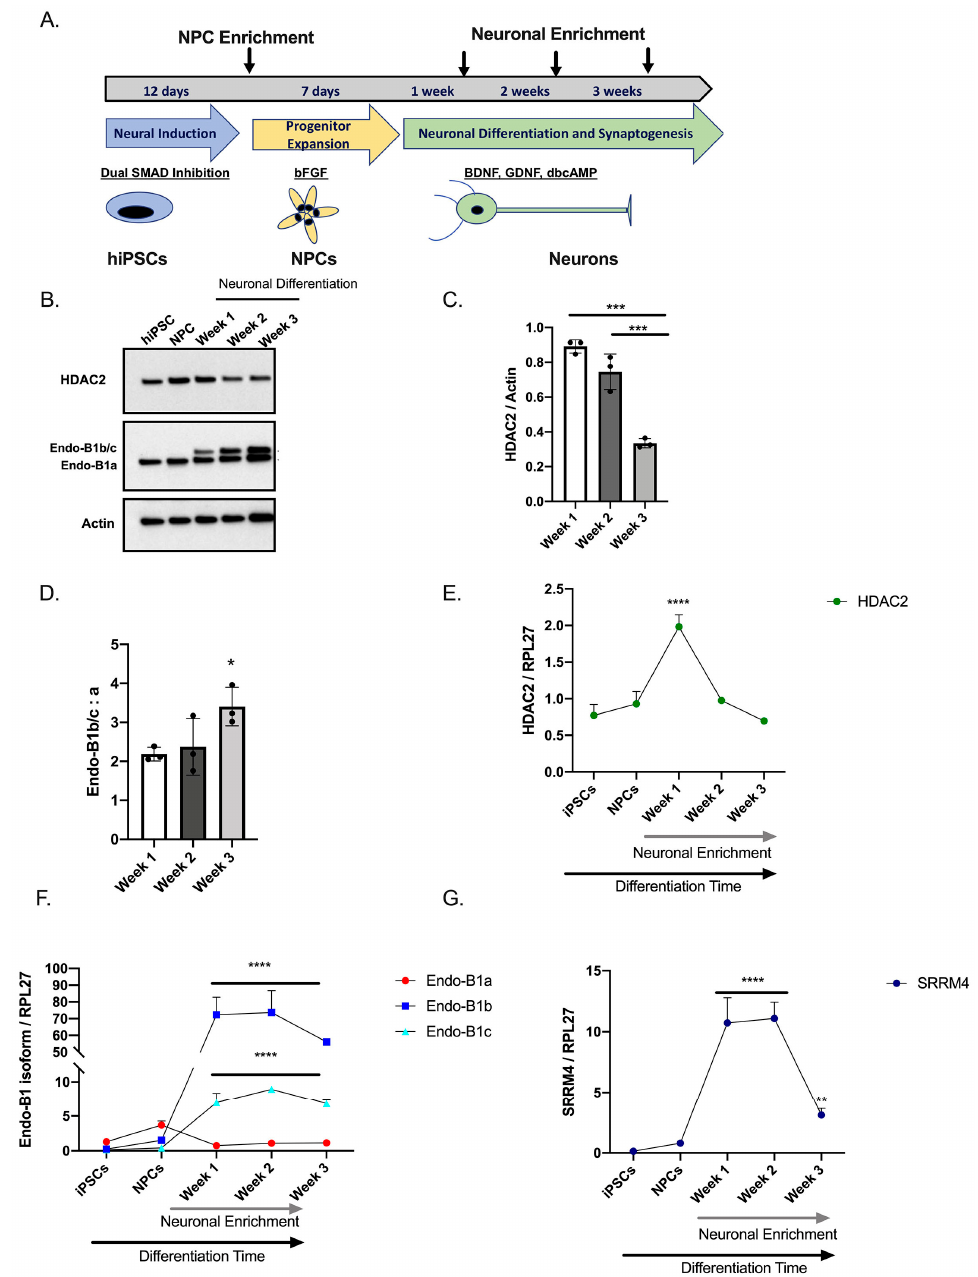
Figure 1. HDAC2 expression is dynamic during neuronal differentiation from hiPSCs and correlates with neuron- specific isoforms of Endophilin-B1, a protein that influences mitochondrial dynamics. ( A ). Schematic of neuronal differentiation protocol from hiPSCs. Arrows indicate time points when NPCs or neurons were enriched by cell sorting. ( B ). Representative Western blot analysis of endogenous HDAC2 and Endophilin-B1 levels in hiPSCs, NPCs, and during neuronal differentiation. Endo-B1a = ubiquitous isoform, Endo-B1b/c = neuron-specific isoforms. Note: Endo-B1b and Endo-B1c cannot be resolved on Western blot [13,28,32] and are indicated as Endo-B1b/c. ( C ). Quantification of HDAC2 protein decreases during a three-week neuronal differentiation ( N = 3, *** p < 0.001 by one-way ANOVA with Tukey’s multiple comparisons test). ( D ). Quantification of the ratio of Endo-B1b/c to Endo-B1a protein isoforms during neuronal differentiation ( N = 3, * p < 0.05 by one-way ANOVA with Tukey’s multiple comparisons test). ( E ). Endogenous HDAC2 mRNA harvested from hiPSCs, NPCs, and neuronally enriched cultures harvested at 1, 2, and 3 weeks of differentiation. HDAC2 mRNA expression increases during the first week of neuronal differentiation and then decreases substantially as neurons mature ( N = 3, **** p < 0.0001 by one-way ANOVA with Tukey’s multiple comparisons test). ( F ). Quantification of Endo-B1a , Endo-B1b , and Endo-B1c